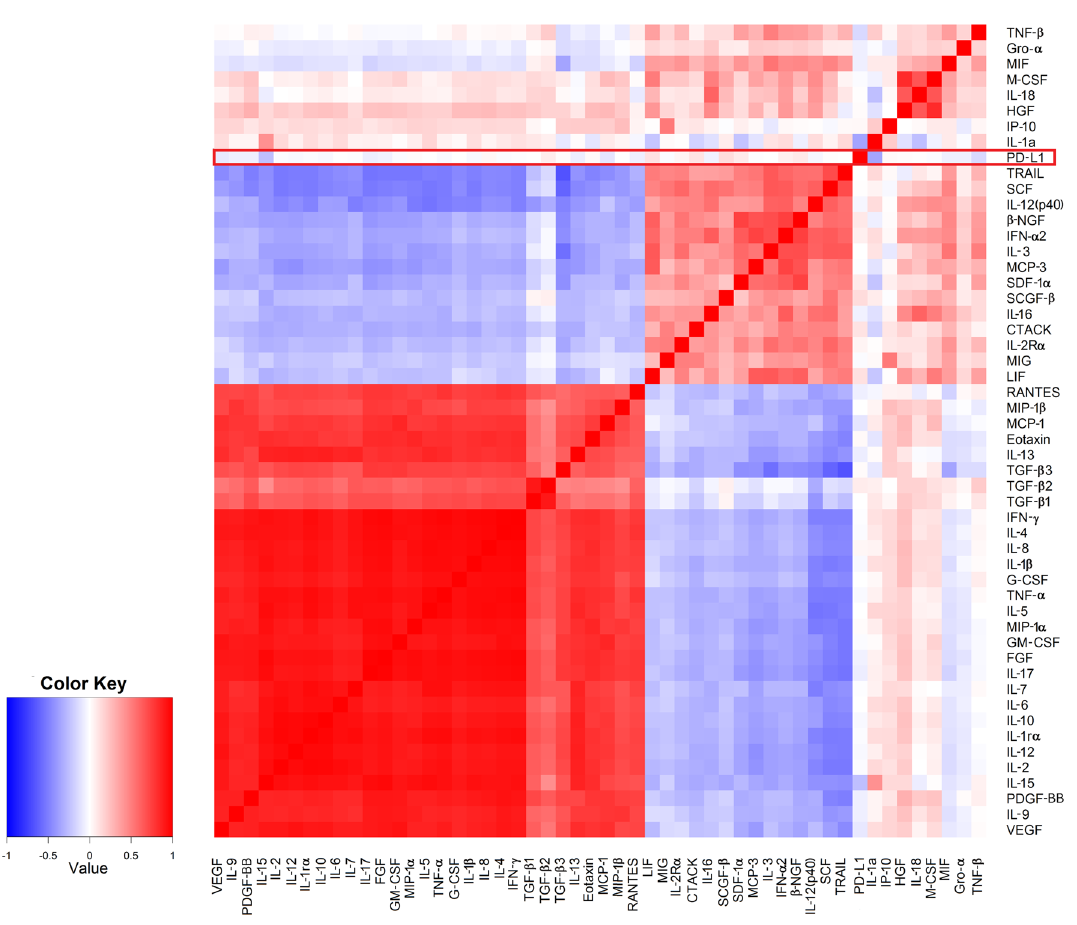
Figure 4. The correlations between PD-L1 and individual